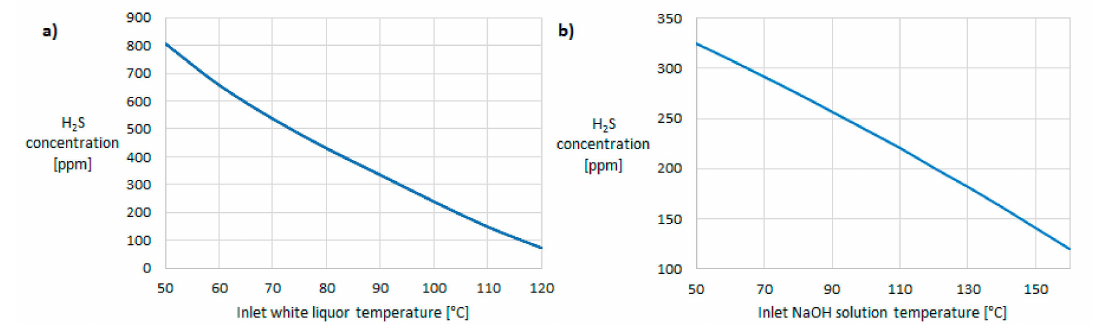
Figure 4. Concentration of H 2 S in cleaned gas depending on the temperature of white liquor at inlet NaOH solution temperature set to 160 ◦ C ( a ), and on the temperature of inlet NaOH solution at inlet white liquor temperature set to 100 ◦ C ( b ), both for constant white liquor flow